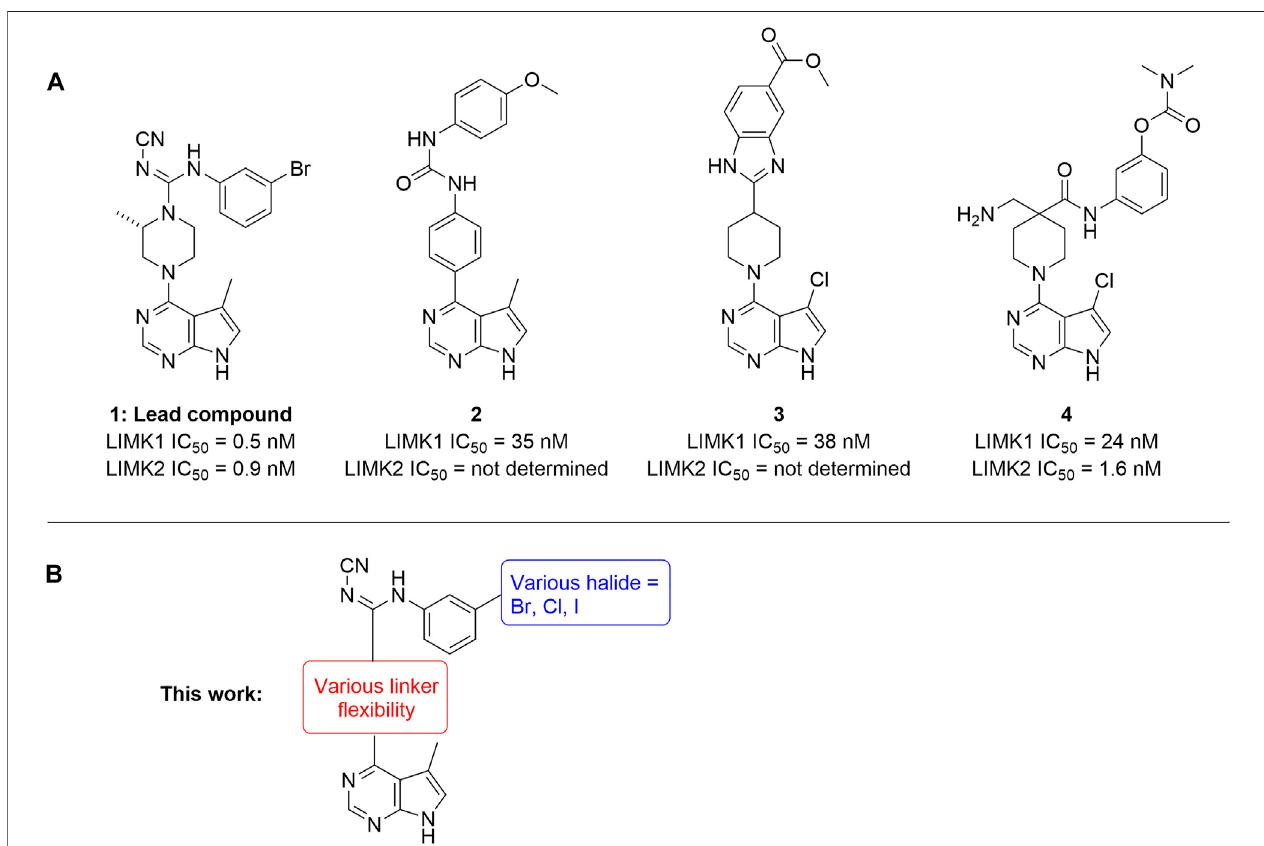
FIGURE 1 | (A) Structure of known pyrrolopyrimidine LIMK inhibitor and their inhibitor pro fi le. (B) Scaffold modi fi cation in this work.